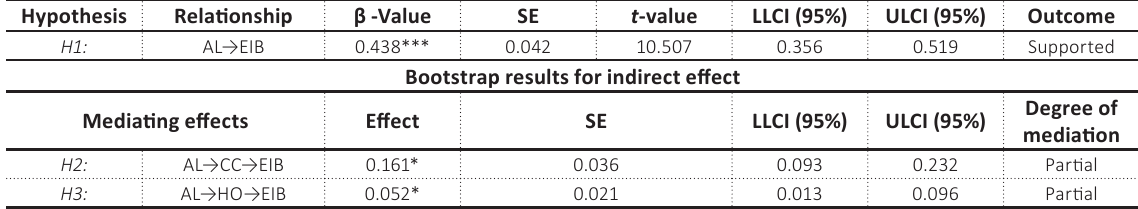
Table 3. Estimates based on the structural model Hypothesis